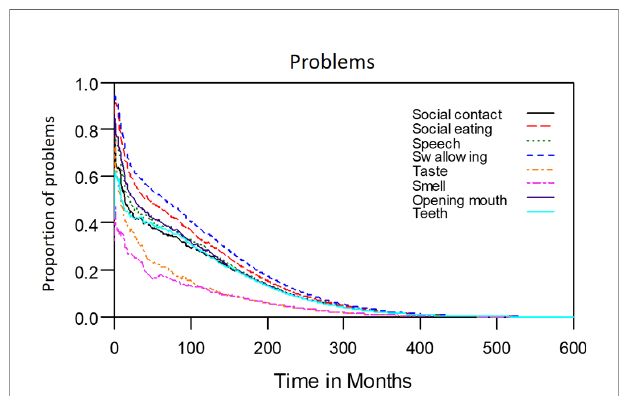
FIGURE 6 | Problems in patients with advanced OSCC. The estimated persistence of impairments or problems are represented by the area under the quality-adjusted survival curve. Duration of functional impairments or problems (years): Taste — 3.6; Smell — 3.0; Speech — 6.5; Swallow — 8.3.